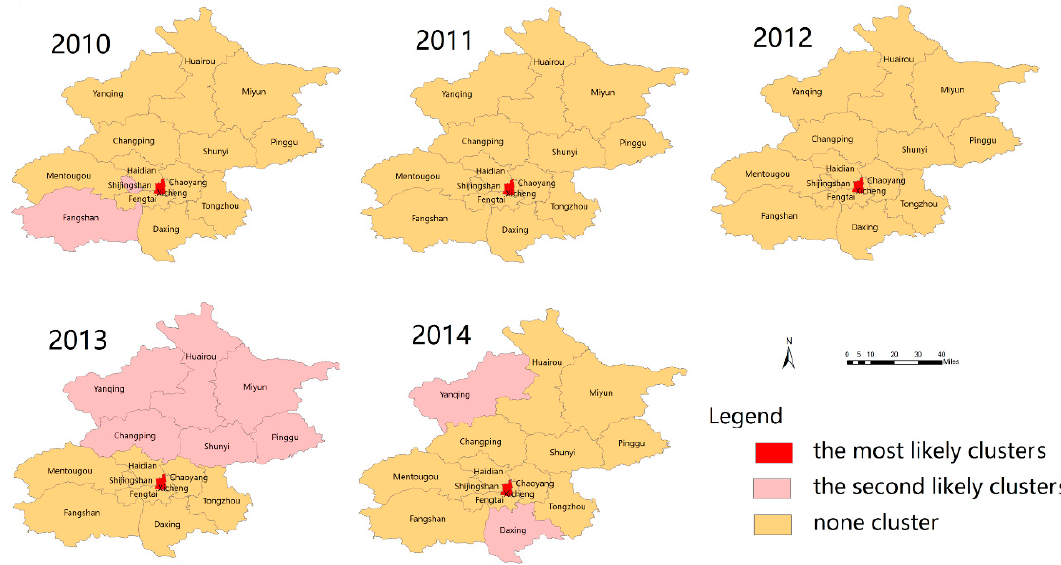
Figure 4. The most likely clusters and the secondary clusters of scarlet fever incidence in Beijing were detected using the Purely Spatial Poisson model, 2005–2014. Red indicates the most likely cluster, slightly red indicates secondary clusters and light red indicates no clusters in the study areas.